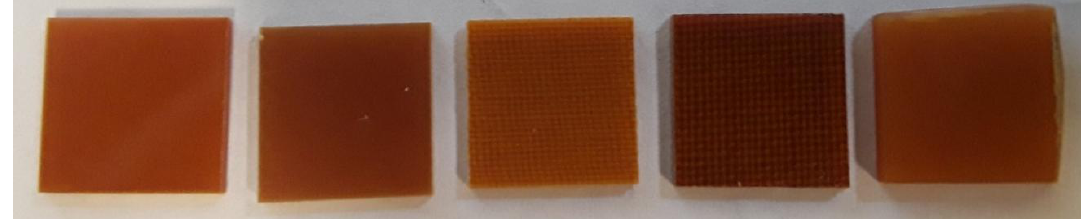
Figure 1. Phenolic resin samples. From left to right: P1, P2, C1, C2, and C3.